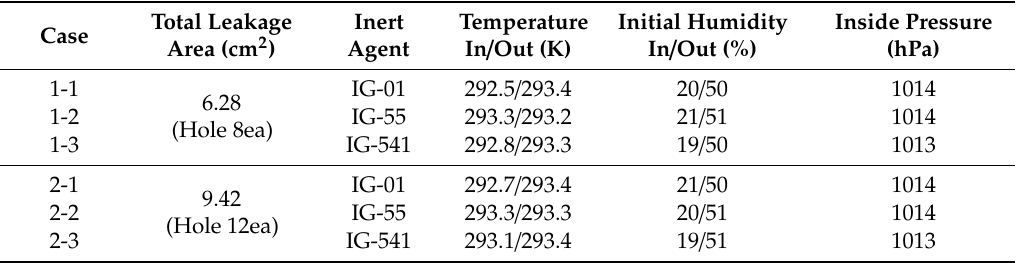
Table 2. Initial conditions inside and outside the enclosure.